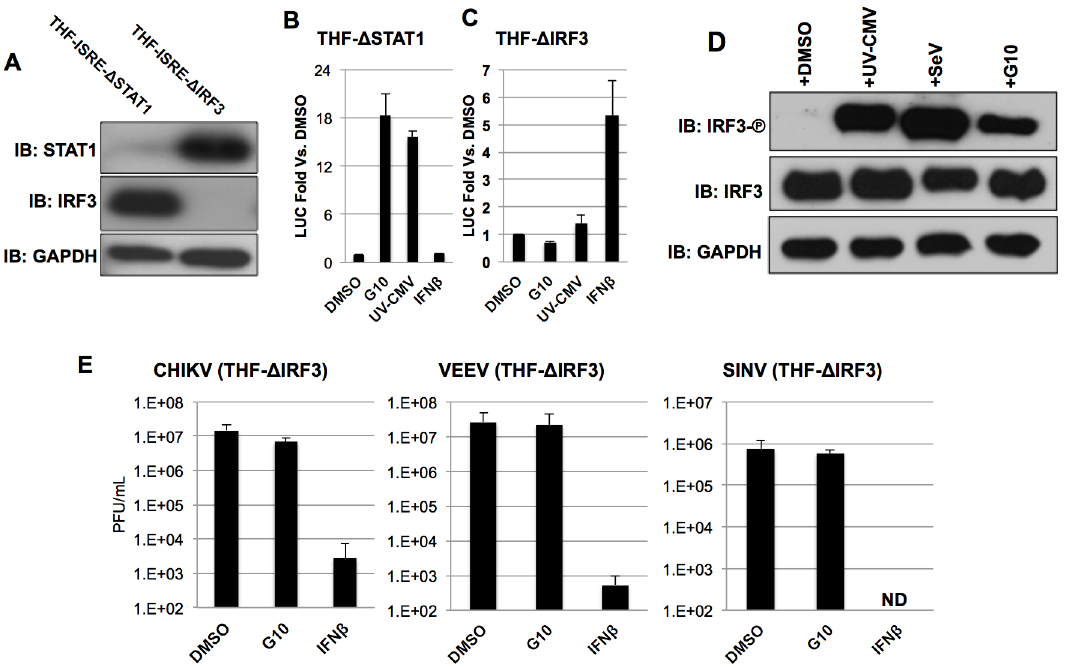
Fig 4. IRF3 is Required for G10-Dependent Transcription and Anti-Alphaviral Activity. (A) Immunoblot showing IRF3, STAT1, and GAPDH in THF-ISRE stably transduced with Cas9 and CRISPR gRNA directed against either STAT1 (THF-ISRE- Δ STAT1) or IRF3 (THF-ISRE- Δ IRF3) as indicated. (B) Induction of IRF3/IFN-dependent LUC in THF lacking STAT1 following 7h exposure to 100 μ M G10, UV-inactivated CMV, or 1000U/mL IFN β . Values displayed are average fold changes ± SD of quadruplicate measurements relative to cells exposed only to 1% DMSO. (C) Induction of IRF3/IFN-dependent LUC in THF lacking IRF3 following 7h exposure to 100 μ M G10, UV-inactivated CMV, or 1000U/mL IFN β . Values displayed are as in B. (D) Immunoblot of lysates from THF-ISRE following 6h exposure to DMSO, UV-CMV, SeV or 100uM G10 as indicated showing phosphorylation status of IRF3 S386, total IRF3, and GAPDH. (E) Average media titers +SD of CHIKV, VEEV, and SINV at 24 (VEEV) or 48hpi (CHIKV, SINV) obtained from THF-ISRE- Δ IRF3 cells treated with 1% DMSO, 100 μ M G10, or 1000U/mL IFN β as indicated. Infections were performed in triplicate.